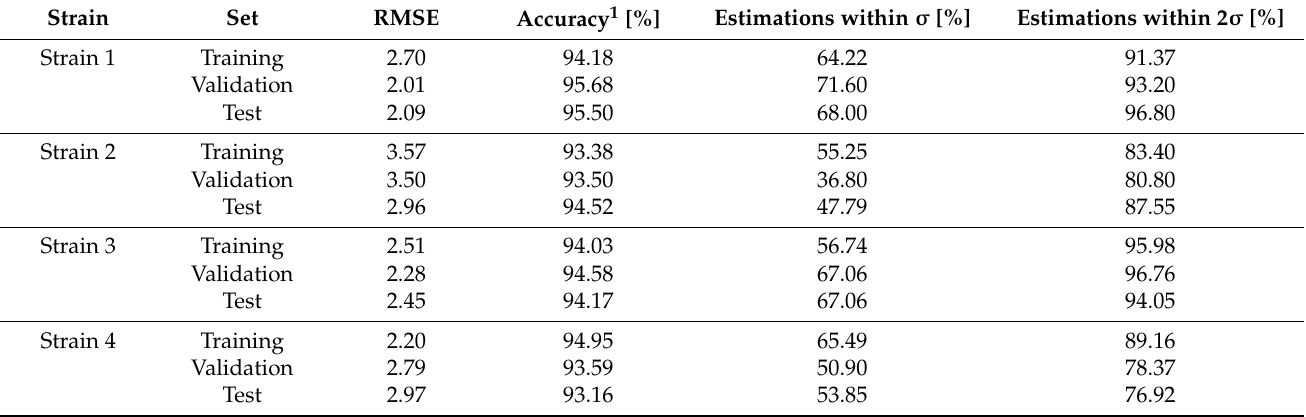
Table A1. Summary of the performance indicators for the strain-specific